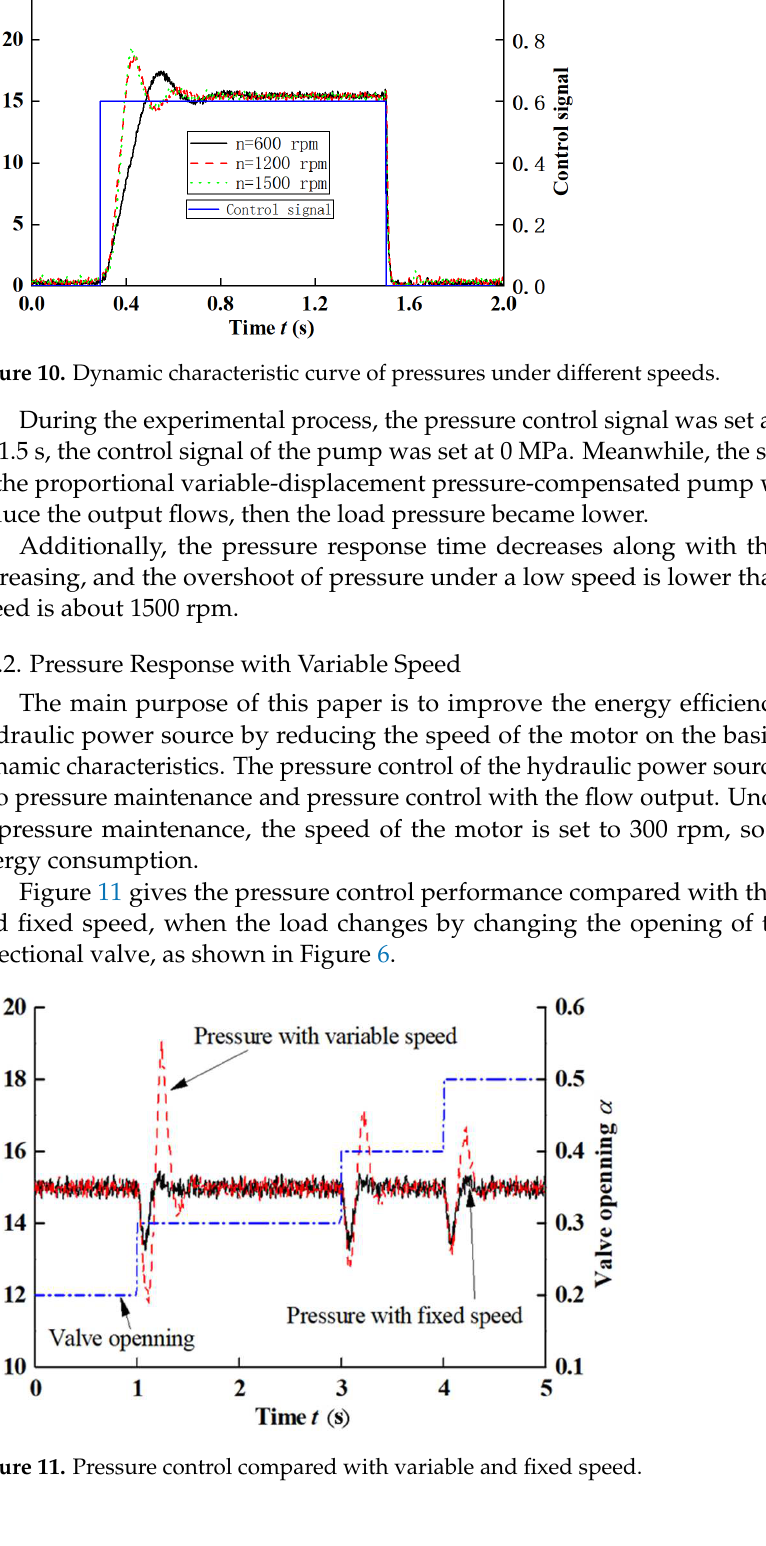
Figure 10. Dynamic characteristic curve of pressures under different speeds.